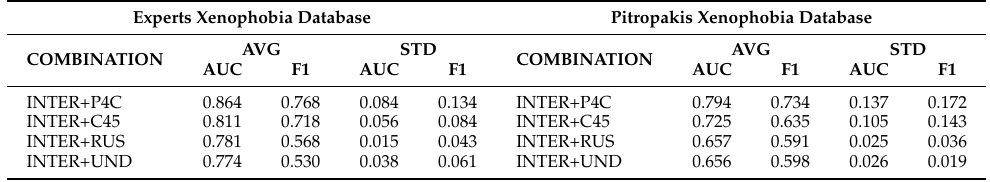
Table 10. Comparison of the interpretable combinations in EXD and